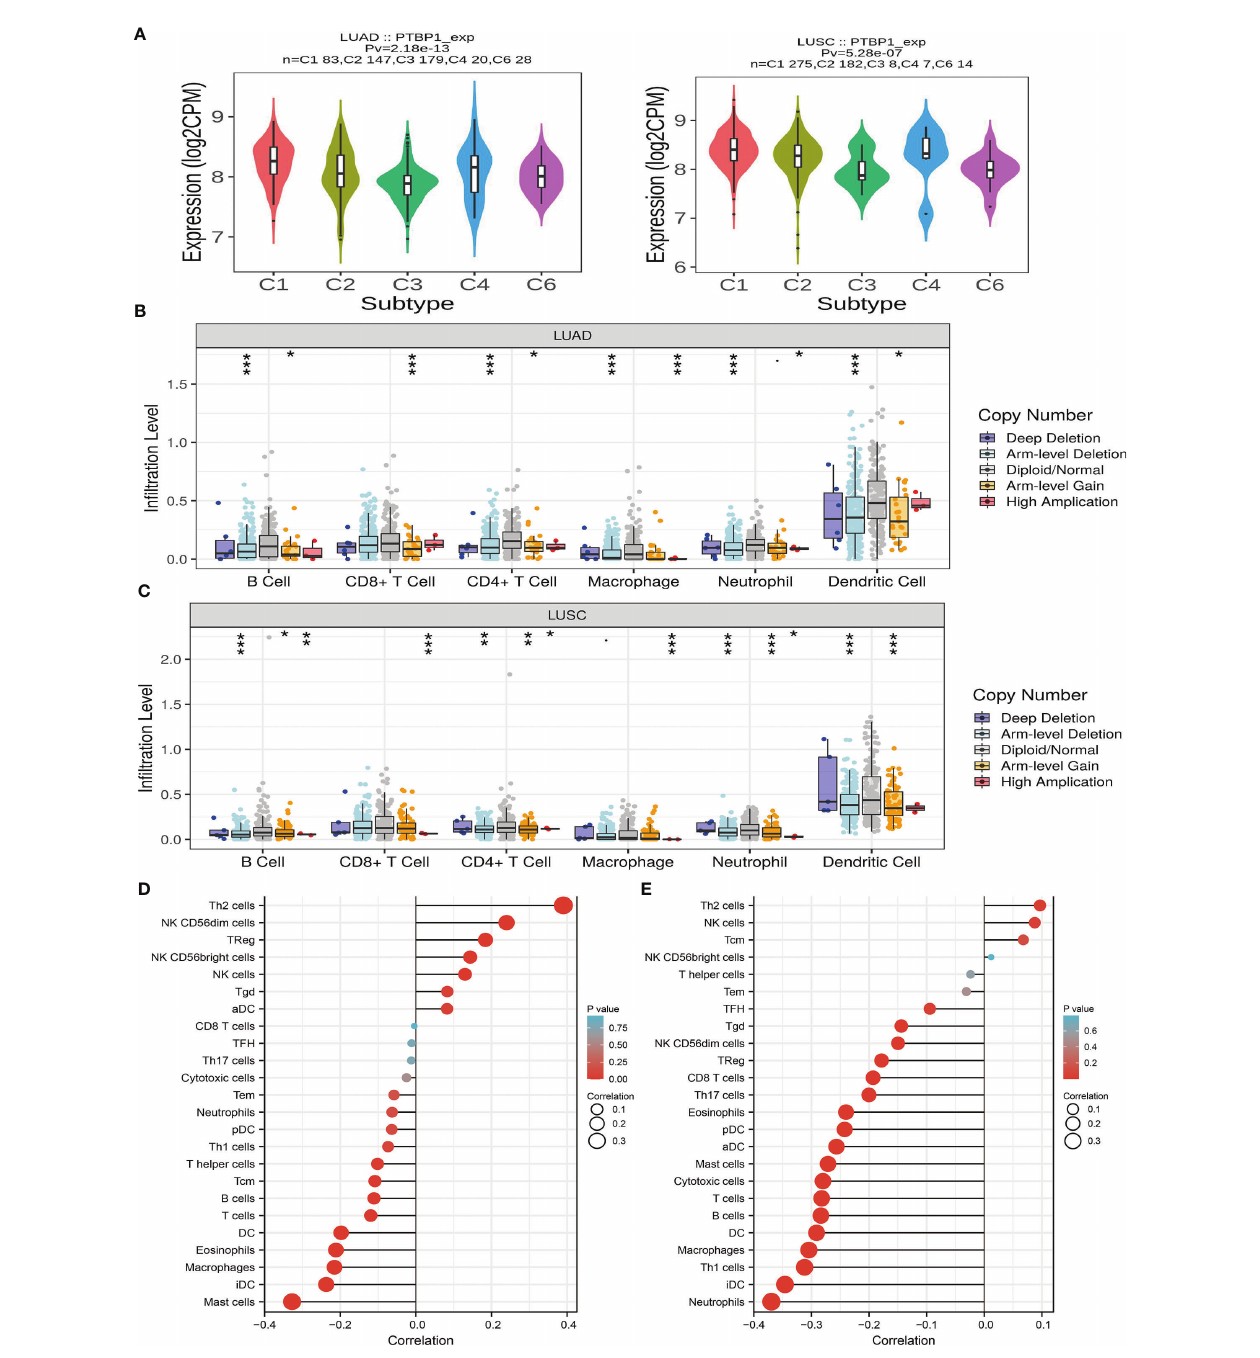
FIGURE 9 | Analysis of the immunological roles of PTBP1 in LUAD. (A) The expression of PTBP1 in immune subtype of LUAD. (B, C) The correlation between tumor in fi ltrating levels and somatic copy number alterations of PTBP1 in LUAD. (D, E) The association between PTBP1 expression and immune in fi ltration level in LUAD. *P<0.05; **P<0.01;